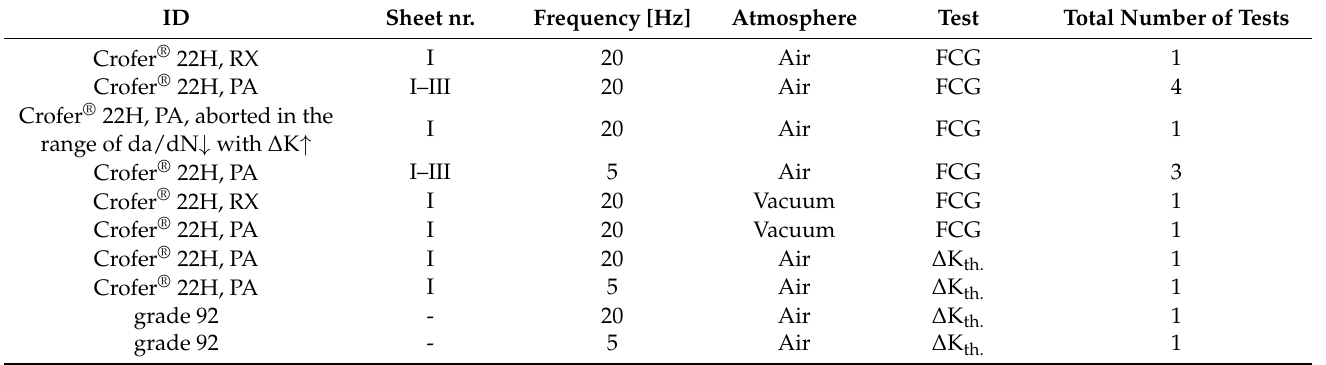
Table 2. Test matrix of FCG and threshold experiments (T = 650 °C, R = 0.1).